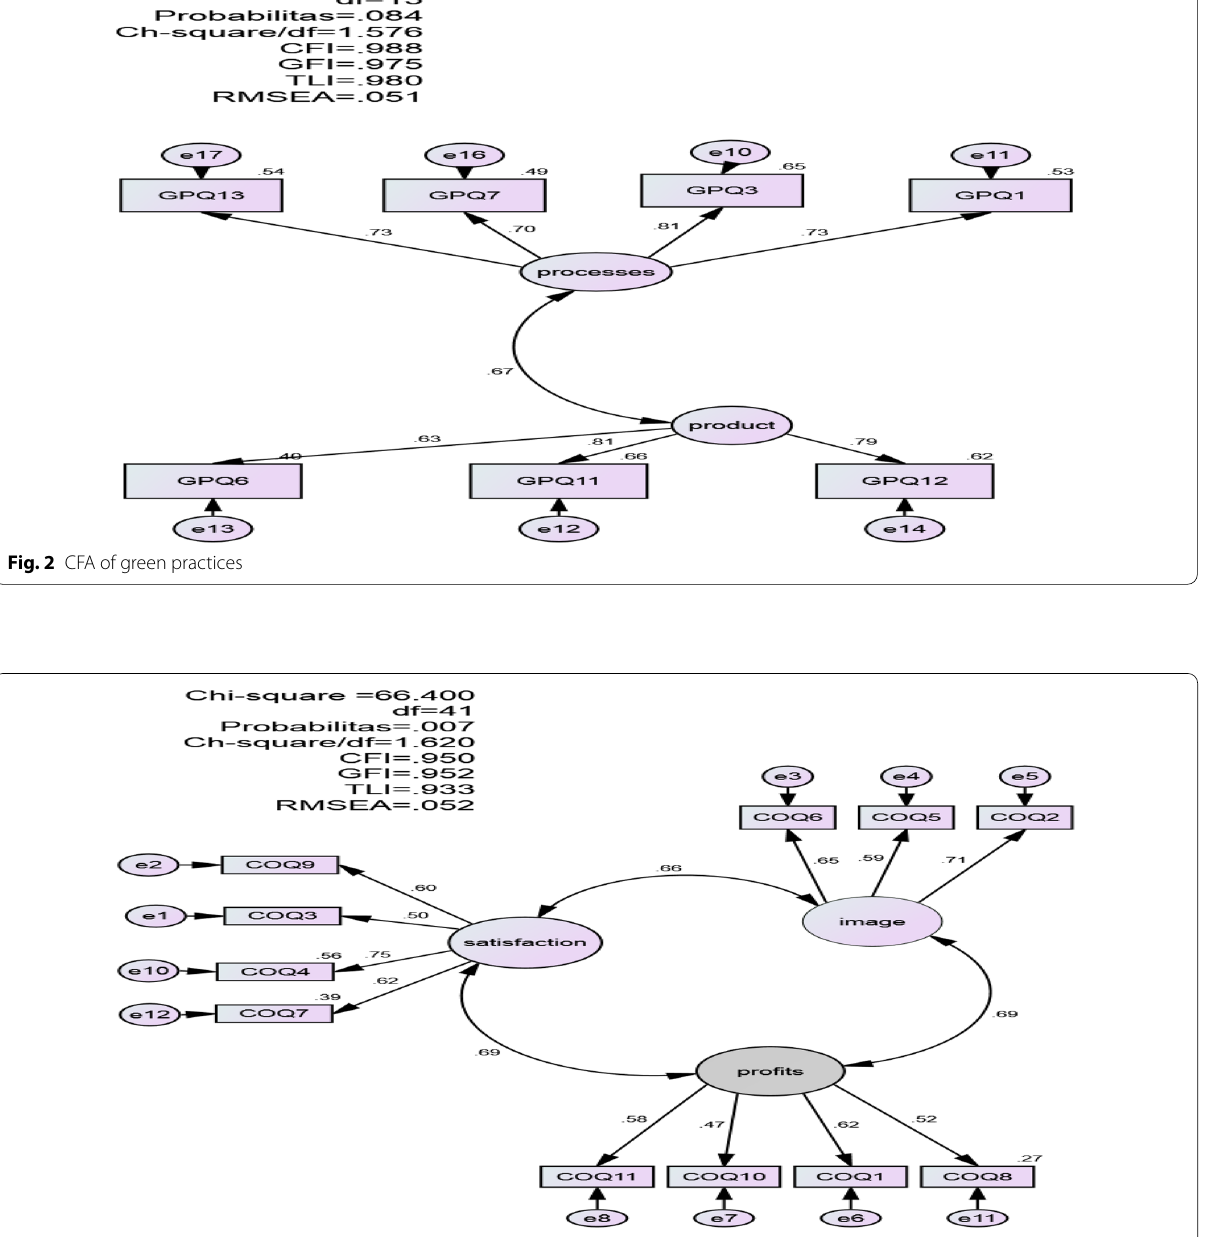
Fig. 3 The hypothesised model of